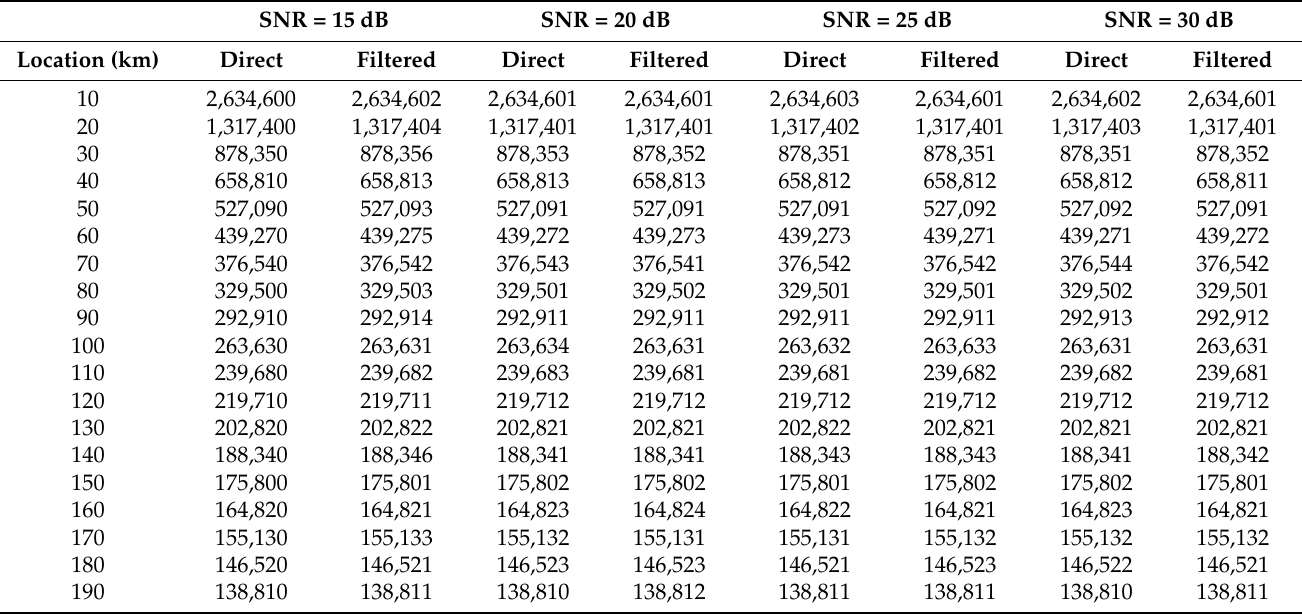
Table 2. Max singular value of FRFT-SVD results at various SNRs for direct and filtered signals under LG fault